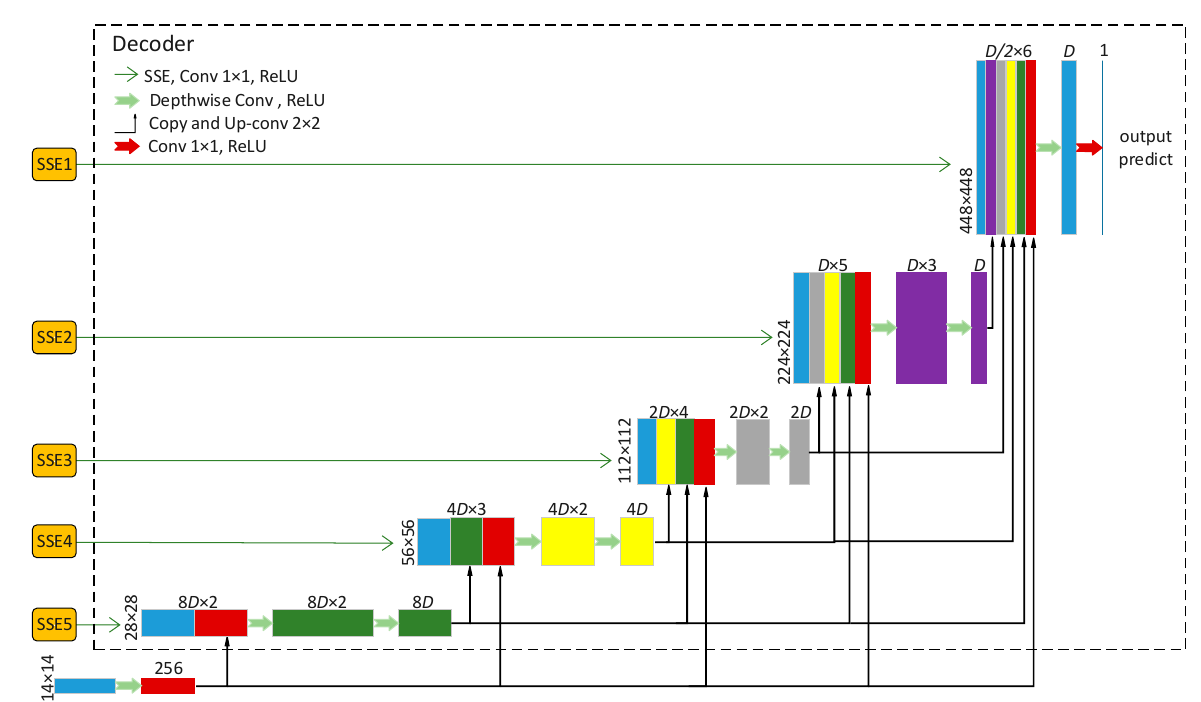
Figure 3. Structure of Decoder module.